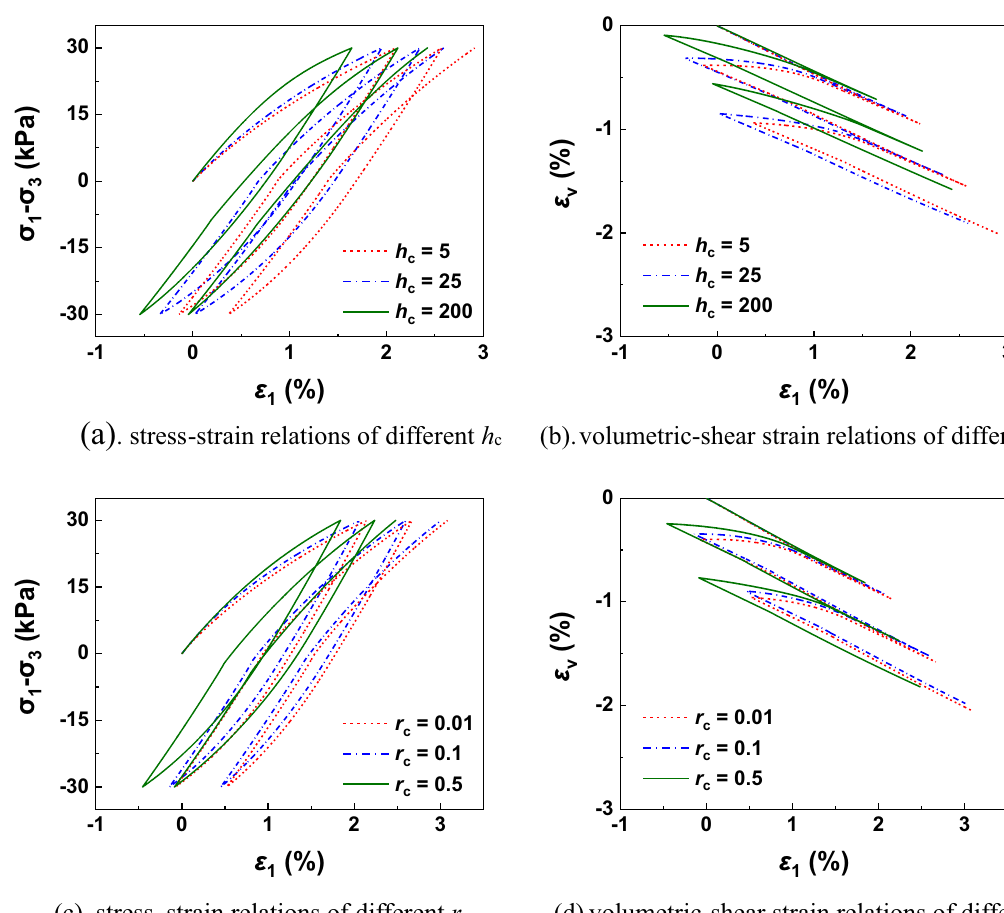
Figure 5. Drained simulations with different values of h c and r c in cyclic loading process.